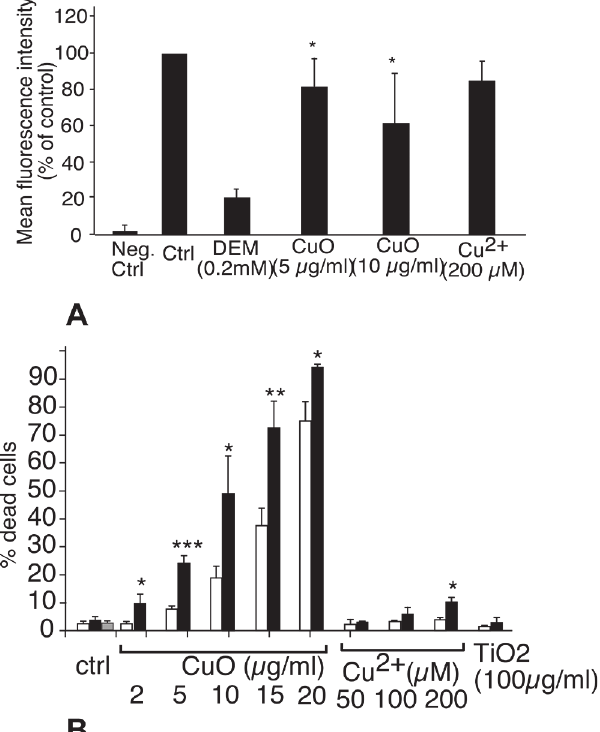
Fig 5. Importance of glutathione in cell survival after treatment with copper. In panel A, the intracellular free glutathione concentration was measured by the monochlorobimane conjugation assay after a 24 hour treatment with copper oxide nanoparticles or copper ion or diethylmaleate (DEM). The results are expressed in % of positive cells compared to the control population. DEM adds to the SH group of glutathione and is used as a control for GSH depletion. In panel B, J774 cells were first treated with 100 μ M buthionine sulfoximine for 6 hours (black bars) or with vehicle (white bars) Copper oxide nanoparticles or copper ion or titanium dioxide nanoparticles were then added at the indicated concentrations for the remaining 18 hours prior to viability measurement. Grey bar: cells treated with buthionine sulfoximine and PVP (4 μ g/ml). Experiments were carried out in quadruplicate. Statistical confidence (Student T-test) is indicated as follows: * : p (cid:1) 0.05; ** p (cid:1) 0.01; *** p (cid:1)